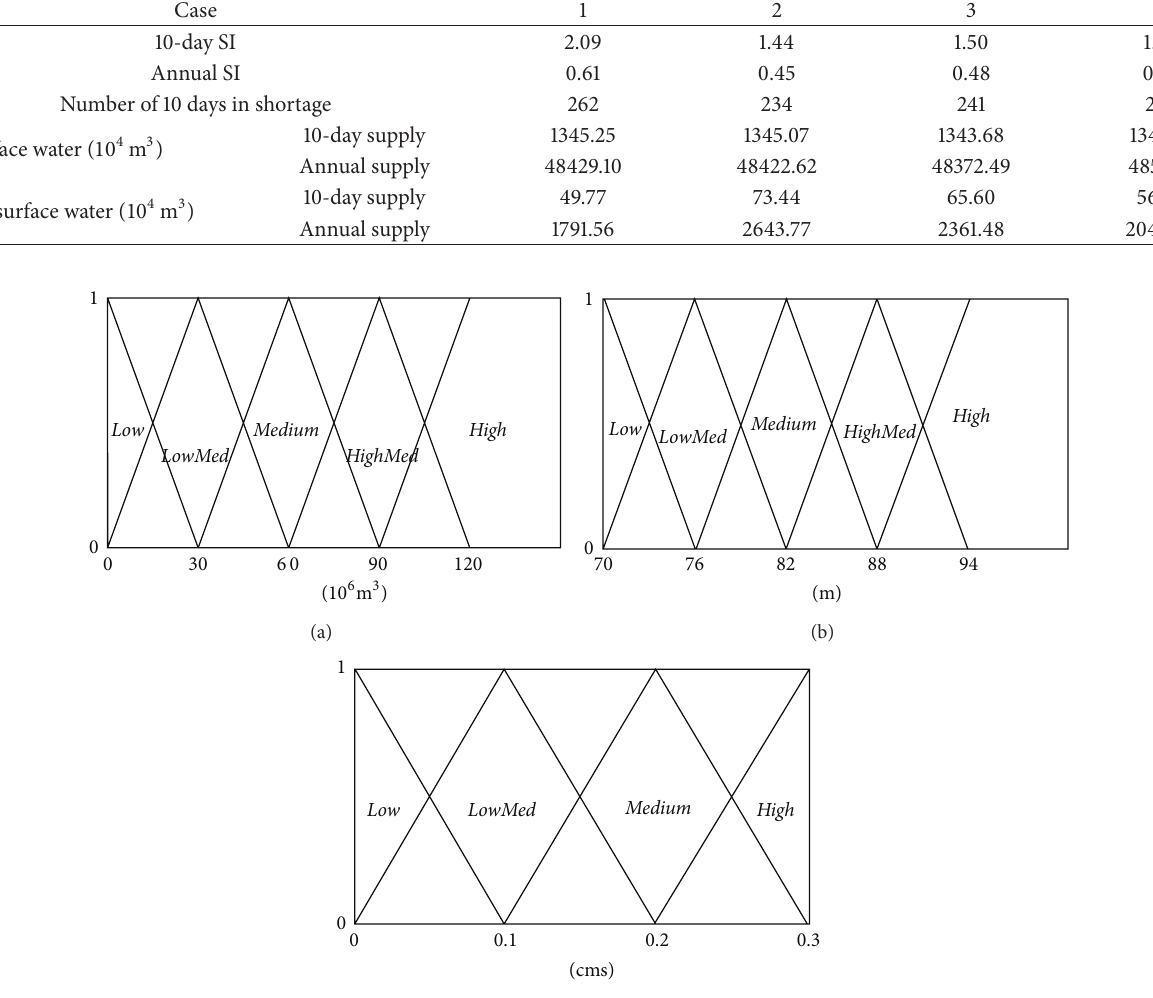
Required demand